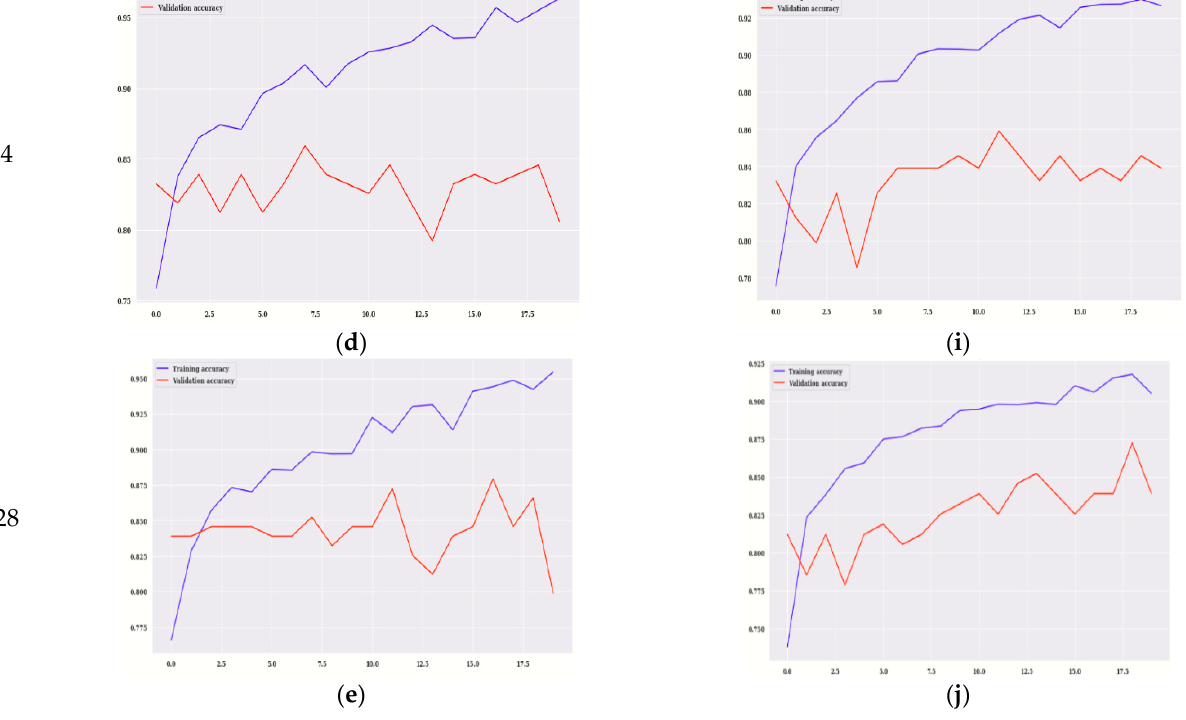
Figure 6. Training Accuracy for VGG16 on Batch size ( a ) 8 ( b ) 16 ( c ) 32 ( d ) 64 ( e ) 128, Training Accuracy for Modified VGG16 on Batch size ( f ) 8 ( g ) 16 ( h ) 32 ( i ) 64 ( j ) 128.